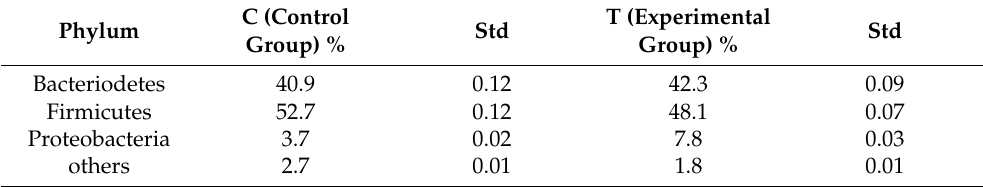
Table 1. Relative abundance of the major phyla in the experimental group and control